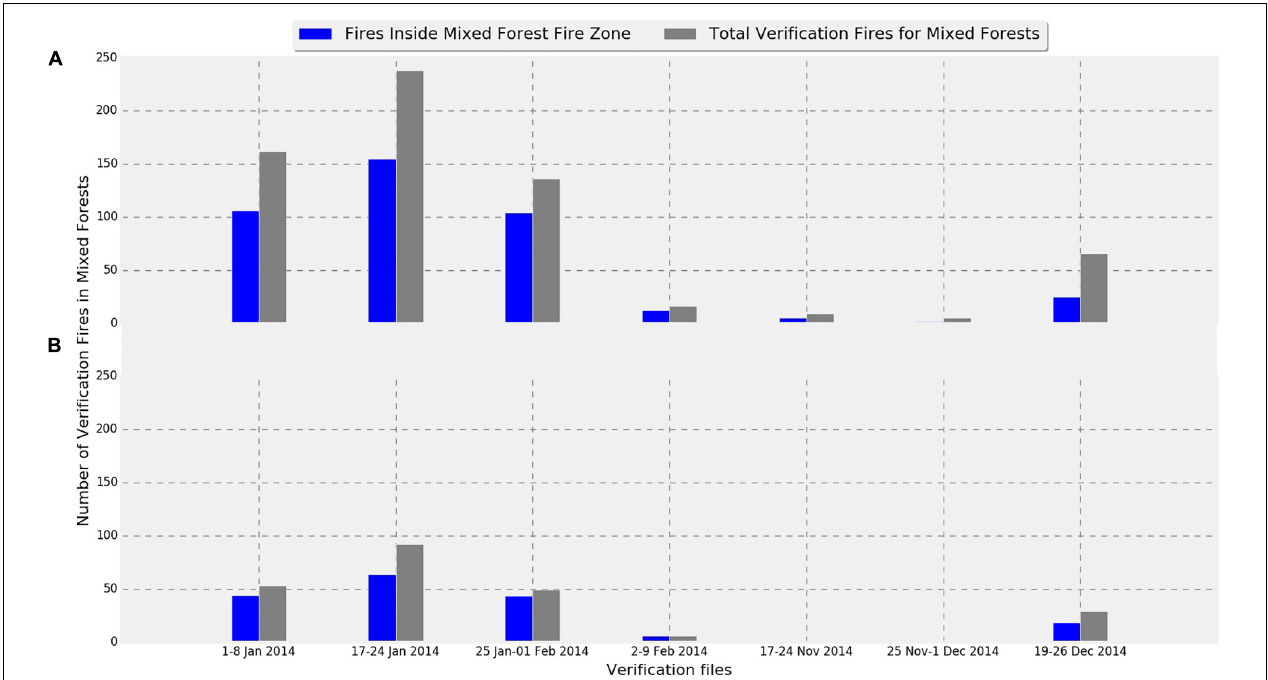
FIGURE 5 | Verification fire distribution in the mixed forest land cover compared to the verification fire falling in the fire zone. (A) Fires with low confidence level ( > 80%), and (B) fires with higher confidence level ( > 95%).